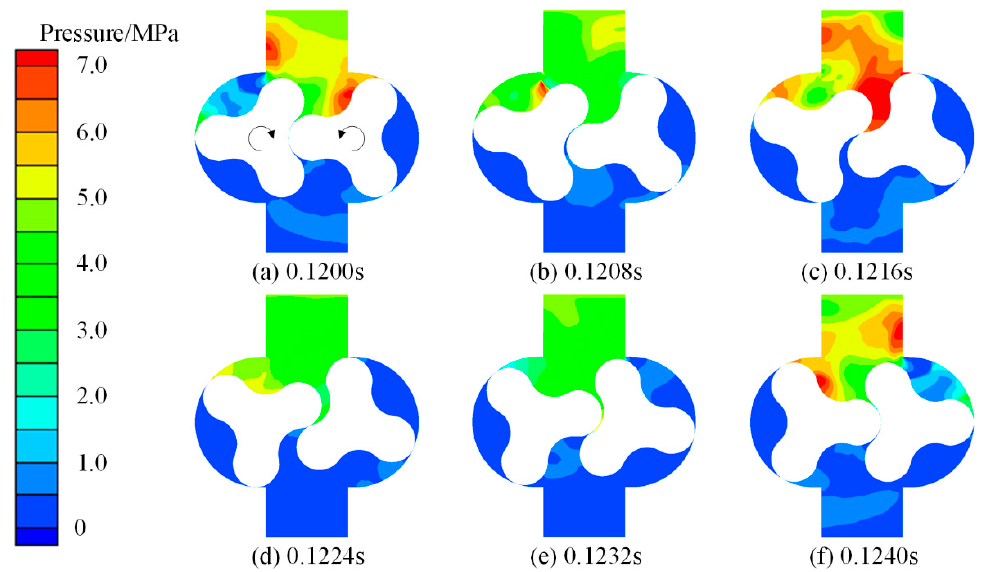
Figure 22. Pressure contours of the Roots pump when the pressure ratio is 10. Flow time: ( a ) 0.1200 s; ( b ) 0.1208 s; ( c ) 0.1216 s; ( d ) 0.1224 s; ( e ) 0.1232 s; ( f ) 0.1240 s.